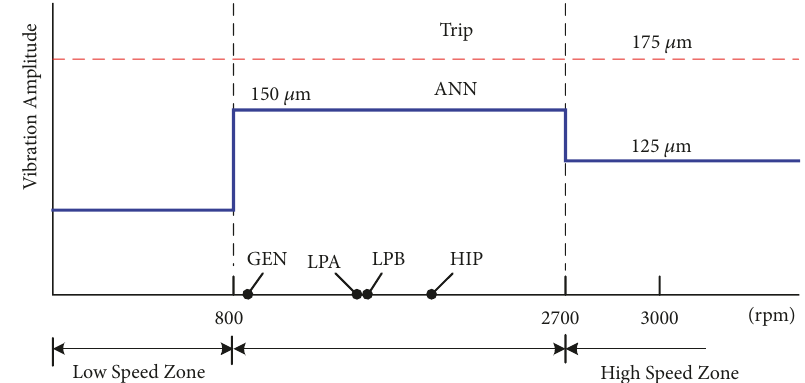
Figure 11: The rotating speed zone of generators.